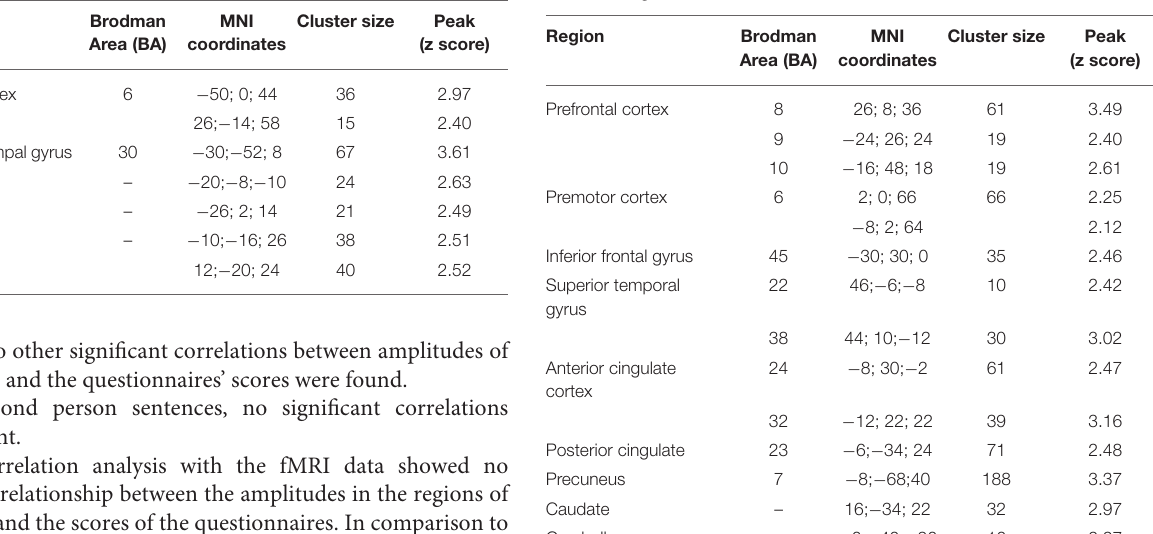
TABLE 3.4 | Main foci of activation for second person sentences in AVI condition contrasted against